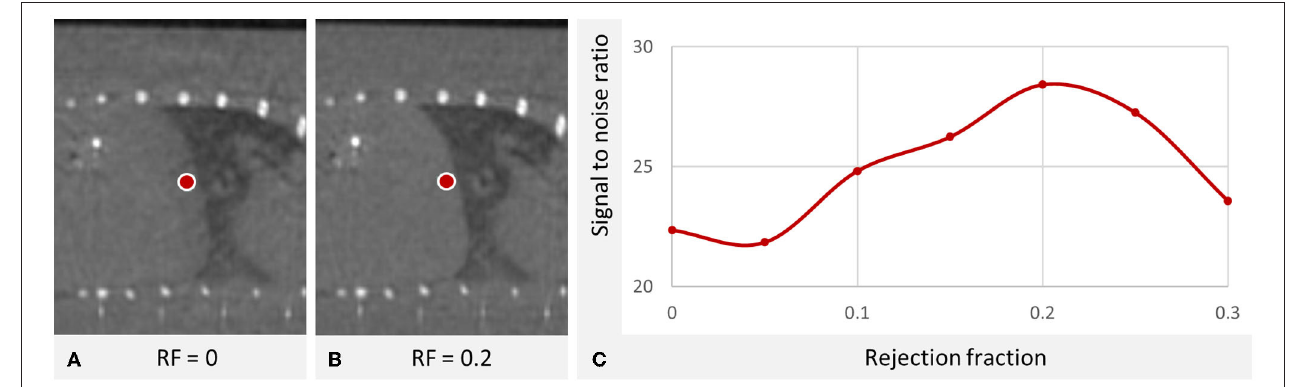
FIGURE 2 | Optimal rejection fraction in a µ CT scan of the liver of a single mouse without contrast agent. (A vs. B) The breathing of the mouse causes a hypodense depiction of the cranial liver parts which is reduced using respiratory gating. W: 2,487 HU L: 50 HU. (C) The signal was measured at the marked cranial liver region for different rejection fractions (RF) showing an optimum at RF = 0.2. ( µ CT device U-CT, MILabs B.V., Utrecht, the Netherlands, continuous rotation mode, tube voltage of 65 kV exposure time 75ms, tube current 0.13mA). The optimum is a compromise for which inconsistent projections are removed with the trade-off that less data is available for